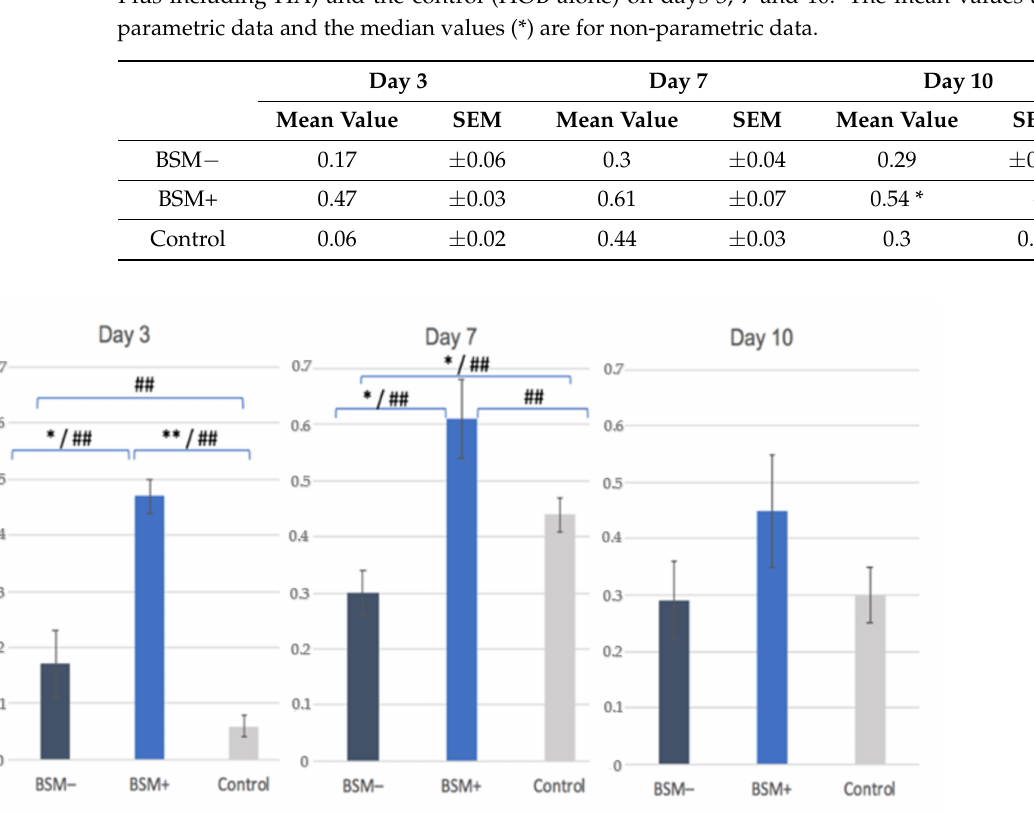
Figure 5. Cell Proliferation: MTT assay, absorbance at 570 nm for BSM − (cerabone ® ), BSM+ (cerabone ® Plus including HA) and Control (HOB alone) on days 3, 7 and 10. * = p ≤ 0.05, t -test; ** = p ≤ 0.001, t -test; ## = p ≤ 0.05,